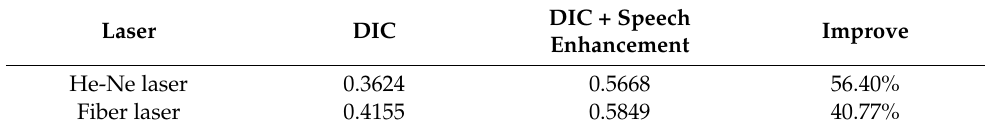
Table 8. Comparison of the speech reconstruction accuracies of two laser datasets.